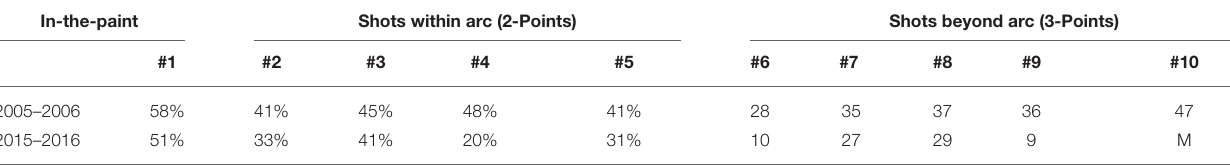
TABLE 2 | Kobe bryant shooting accuracy: 2005–2006 vs. 2015–2016.